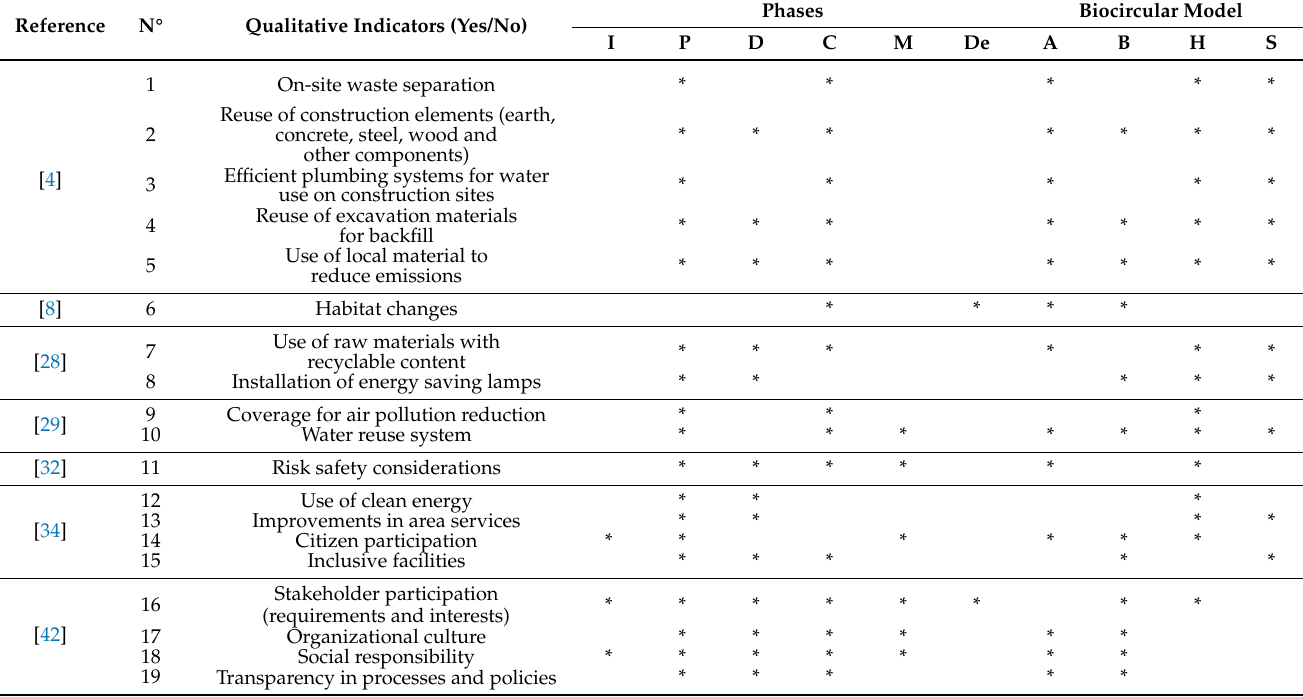
Table 4. Qualitative indicators evaluated by the biocircular